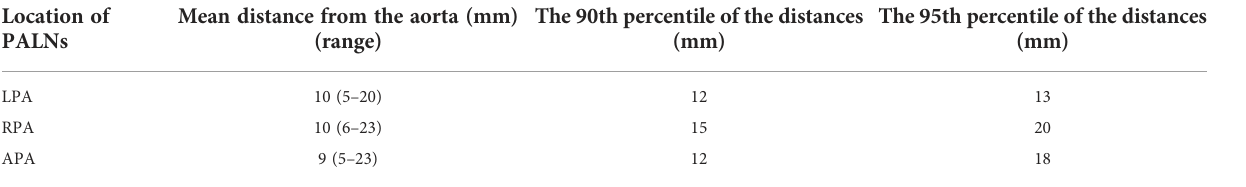
TABLE 4 Distance from the aorta to the volumetric center of the PALN in LN16a2 and LN16b1 in the validation cohort. Location of Mean distance from the aorta (mm) PALNs